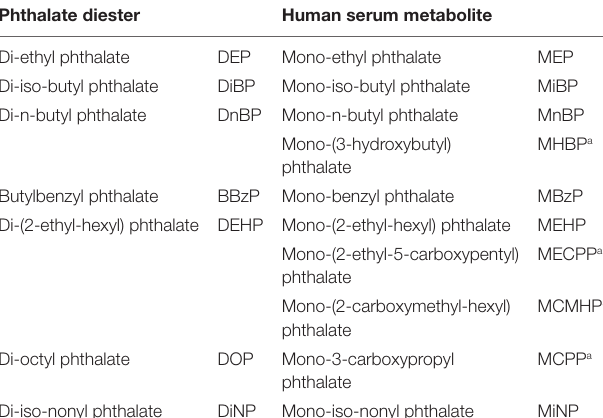
TaBle 1 | Phthalate diesters and their respective metabolites detected in maternal serum during pregnancy and sums of metabolites used for statistical